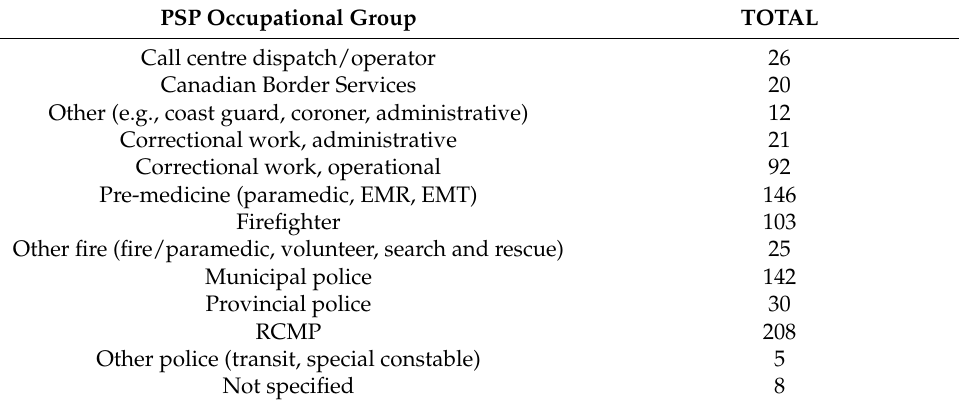
Table 1. Number of PSP participants by